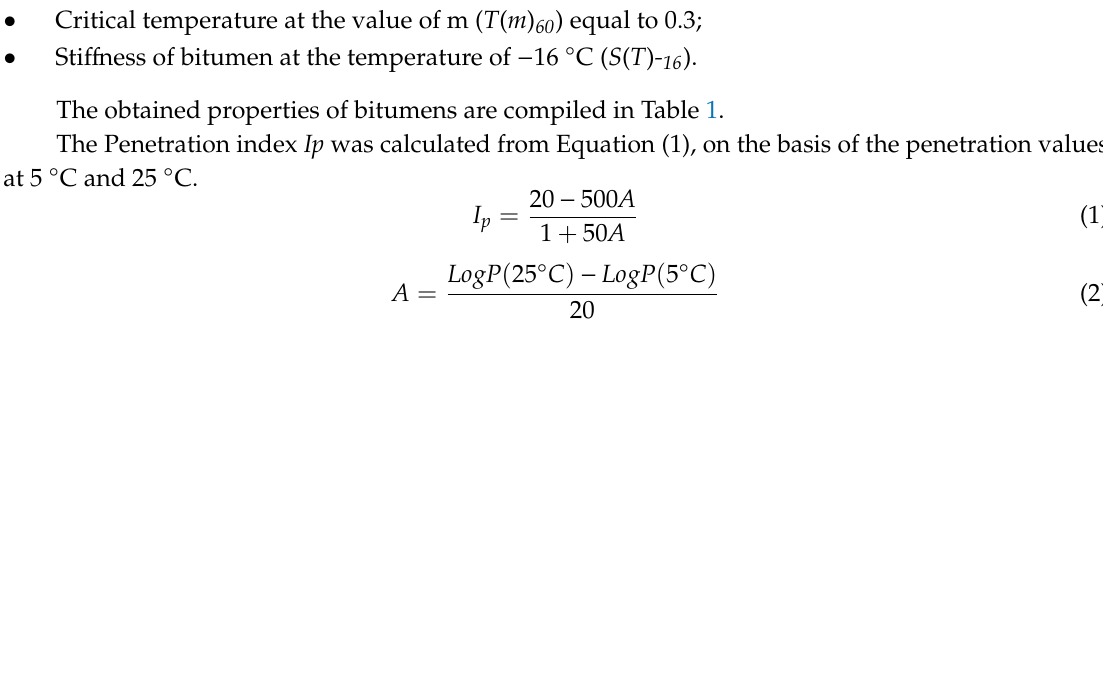
Table 1. Properties of 50/70 paving grade bitumen and two modified bitumens: PMB 45/80-65 and PMB 65/105-60.